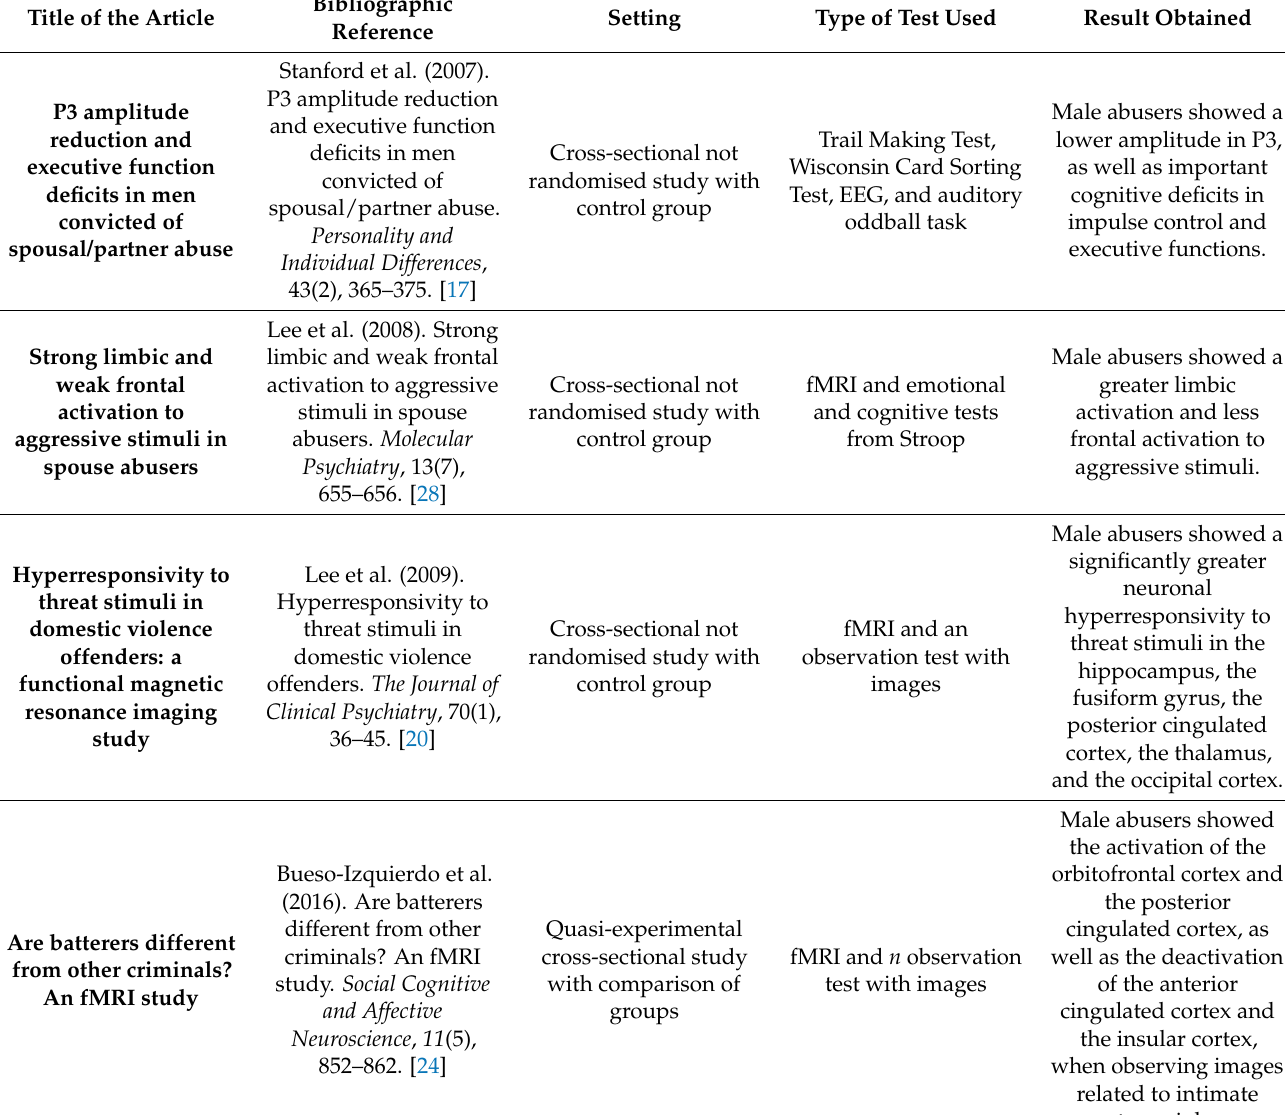
Table 1. Articles, authors, psychological tests, and results obtained in studies with neuroimaging and another test used